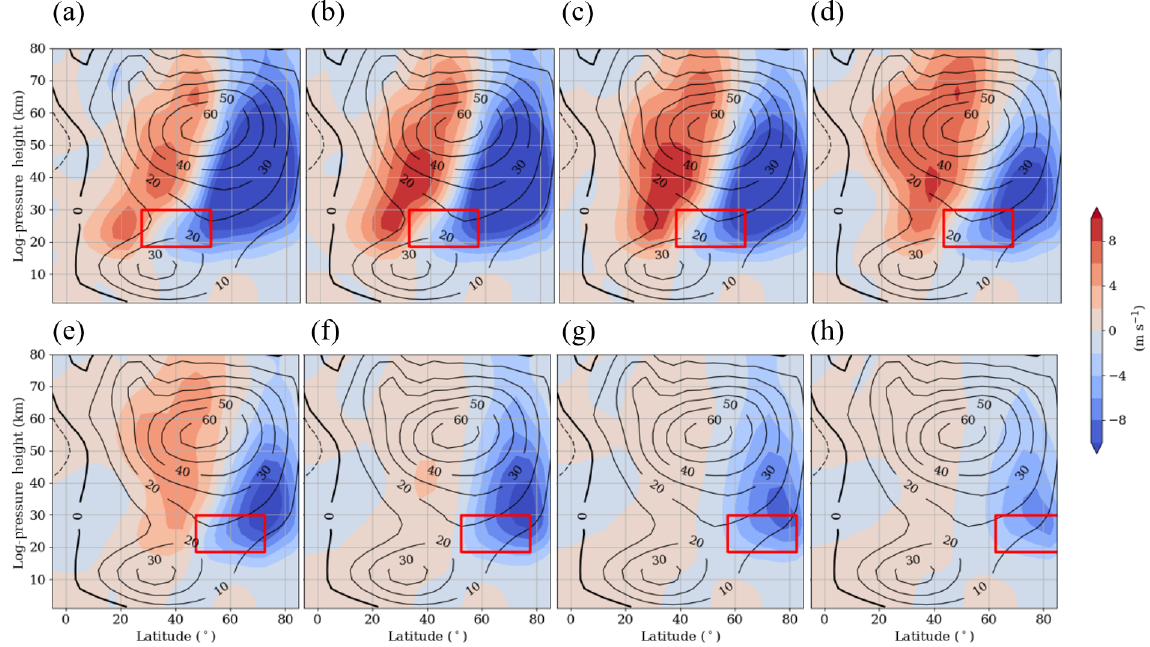
Figure 3. Zonal mean zonal wind difference between the H1–H8 simulations (a–h) and the reference simulation (H1–H8 − Ref). The colors indicate the difference between the simulations, and the contour lines show the zonal mean zonal wind of the reference simulation. Figures represent the last 30d of the simulations. The position of each GW hotspot is represented by a red box.